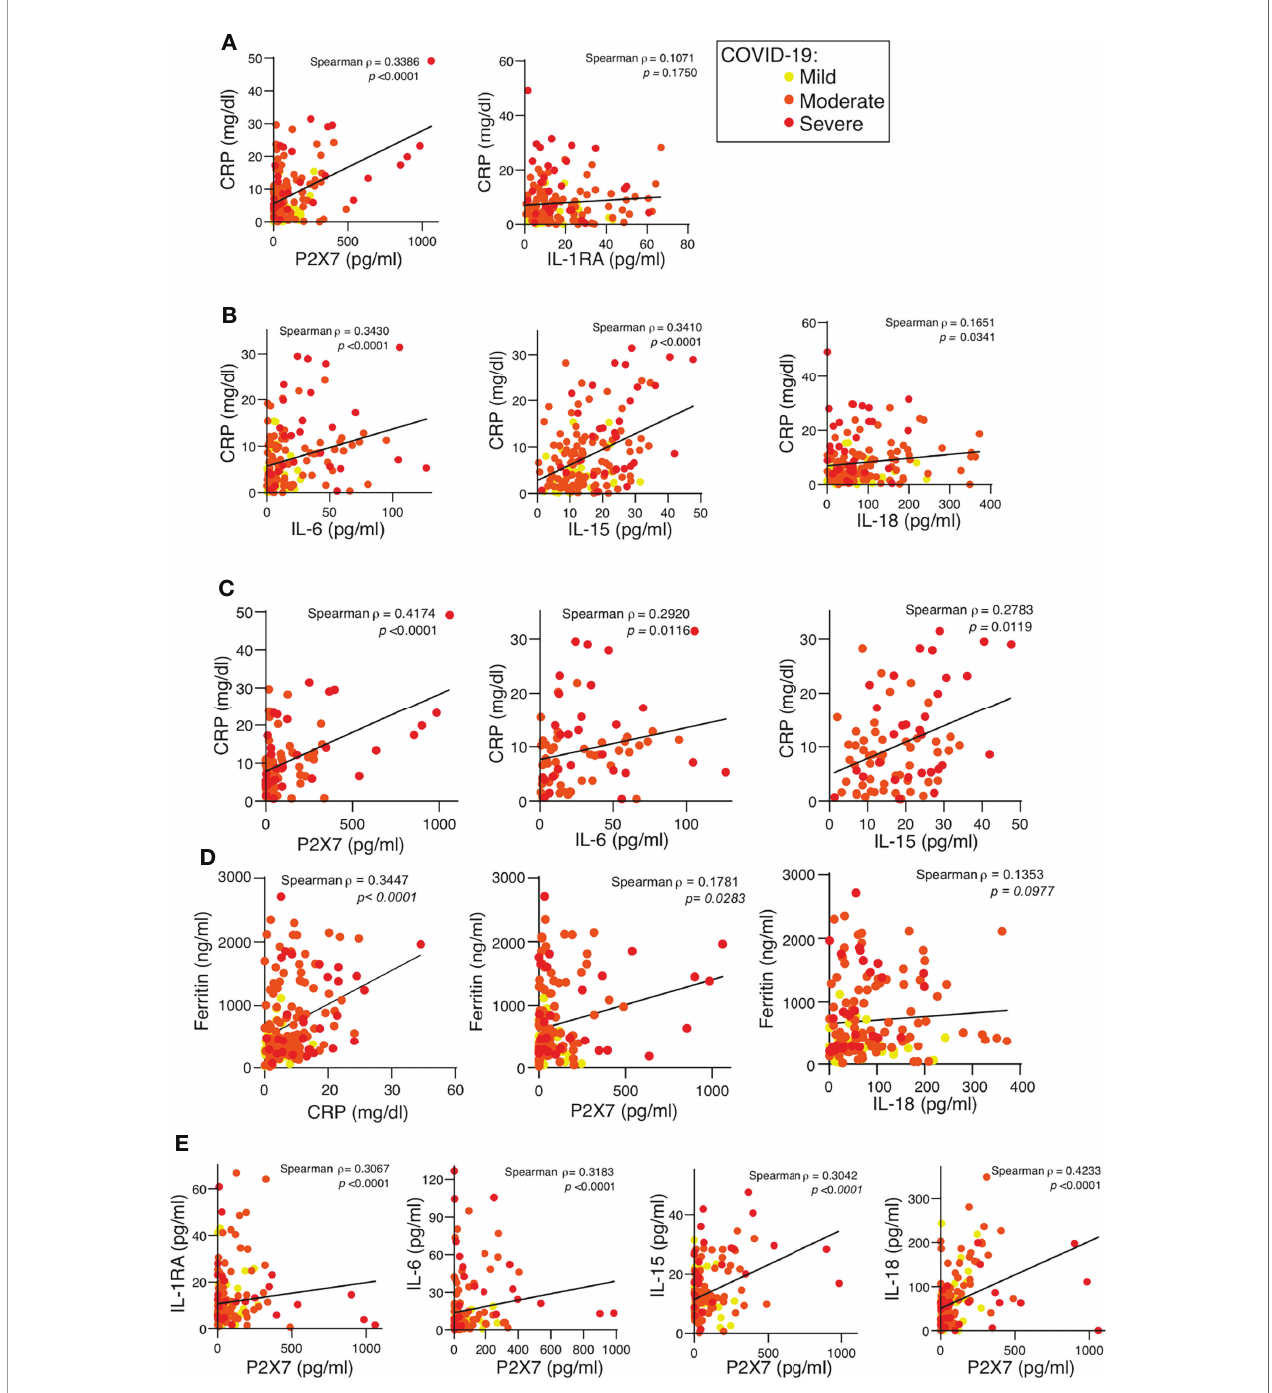
FIGURE 3 | P2X7 receptor detected in the plasma of COVID-19 patients correlates with the C-reactive protein. (A, B) Correlation between the concentration of C- reactive protein (CRP) and the quanti fi cation of the P2X7 receptor, IL-1RA (A) , IL-6, IL-15 and IL-18 (B) in plasma from COVID-19 patients; disease severity is represented with yellow circles (mild), orange circles (moderate) and red circles (severe). (C) Correlation between the concentration of CRP and the quanti fi cation of the P2X7 receptor, IL-6 and IL-15 in plasma from COVID-19 patients with moderate (orange circles) and severe (red circles) COVID-19 manifestation. (D) Correlation between the concentration of ferritin and CRP, P2X7 receptor and IL-18 in plasma from COVID-19 patients; disease severity is represented with yellow circles (mild), orange circles (moderate) and red circles (severe). (E) Correlation between the concentration of the P2X7 receptor and IL-1RA, IL-6, IL-15 and IL-18 from plasma of COVID-19 patients; disease severity is represented with yellow circles (mild), orange circles (moderate) and red circles (severe). Each dot represents an individual patient; Spearman correlation for all